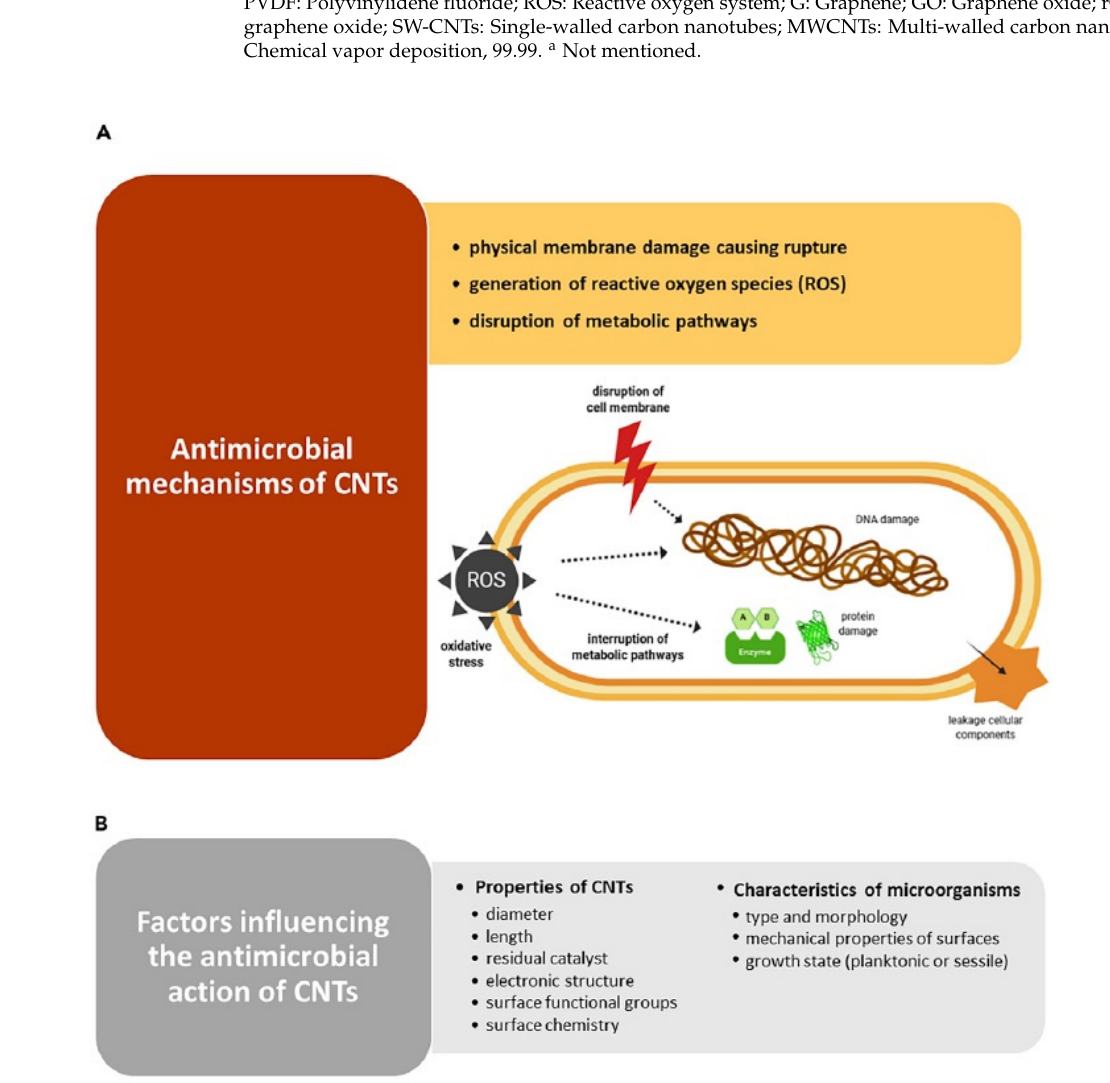
Figure 1. Mechanism of anti-microbial activity of carbon nanomaterial